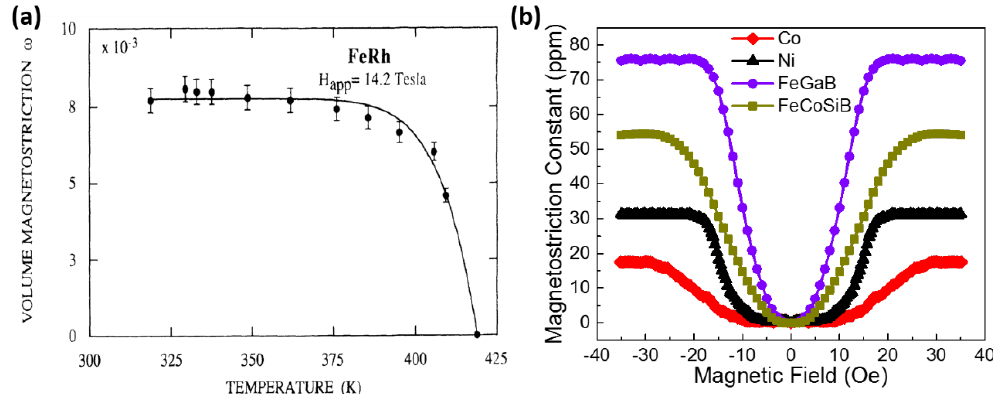
Figure 3. ( a ) Thermal dependence of the volume magnetostriction at 14.2 T for FeRh (the line is a visual guide). Reprinted with permission from [65]. Copyright [1994], American Physical Society. ( b ) Measurement results of the magnetostriction constant in the absolute value of different magnetic thin films (the line is a visual guide).